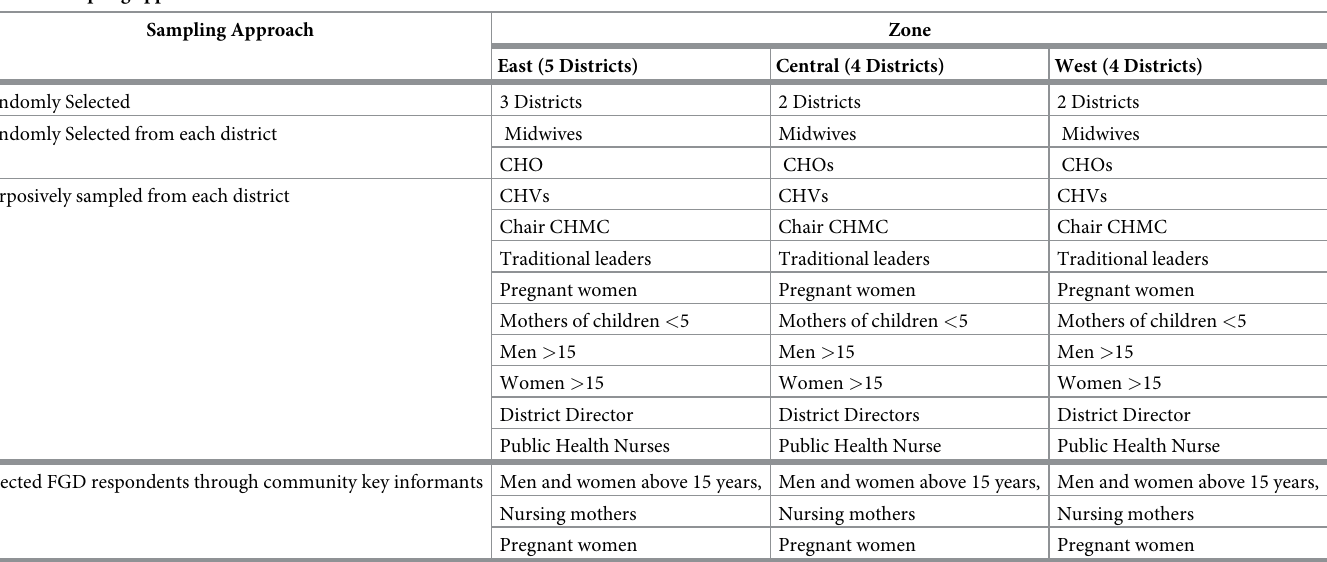
Table 1. Sampling approach. Sampling Approach